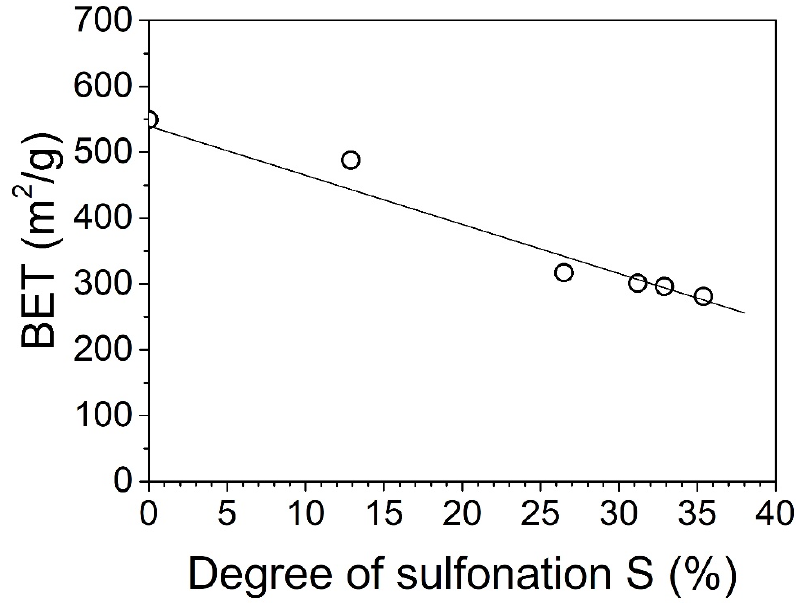
Figure 5. Variation of the surface area (BET) of PPO aerogels with different degrees of